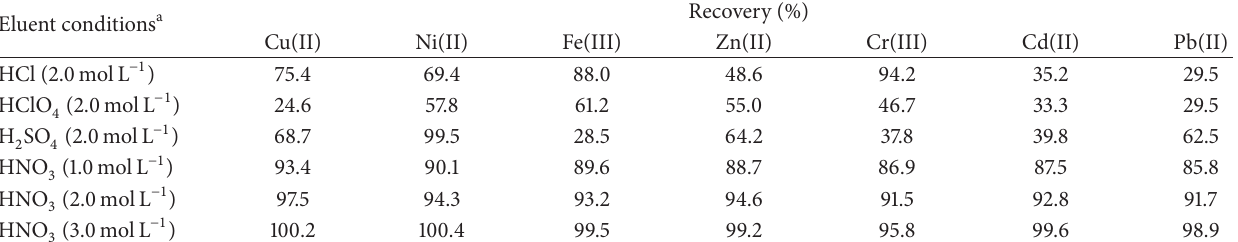
Table 1: Effect of type and concentration of eluting agent on the recovery of analytes ( 𝑁 = 4 ). Eluent conditions a